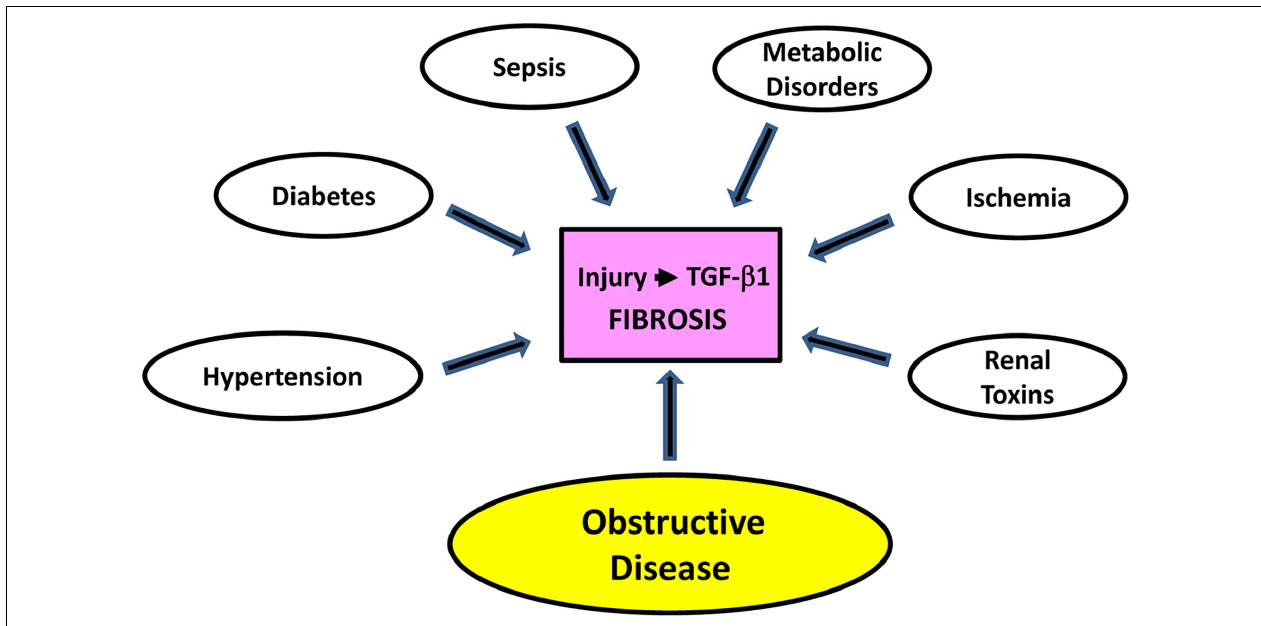
FIGURE 1 | Contributors to renal damage. Extensive trauma or episodic epithelial injury, regardless of etiology and usually in the context of persistent transforming growth factor- β 1 (TGF- β 1) pathway activation, initiates and sustains a program of maladaptive repair that facilitates the progression of AKI to CKD. While diabetes and hypertension are preeminent initiators of CKD, sepsis, metabolic disorders, ischemia/reperfusion injury, exposure to nephrotoxins, and obstructive nephropathy are other significant causative factors. Several animal models of renal injury lend themselves to the discovery of genes and pathways that contribute to the onset and progression of kidney fibrosis. Unilateral ureteral obstruction (UUO) in rodents (either complete or partial/reversible), for example, is one of the most widely used as it approximates the pathophysiology of human obstructive nephropathy in children and adults. Ureteral ligation is a relatively simple procedure and produces a highly reproducible pathological response over a short time course with minimal inter-animal variability. UUO provides a translationally-relevant in vivo platform to probe the genomic complexity of kidney injury, mechanisms underlying maladaptive repair and the efficacy of new therapeutic approaches to the management of fibrotic disease (Martínez-Klimova et al.,